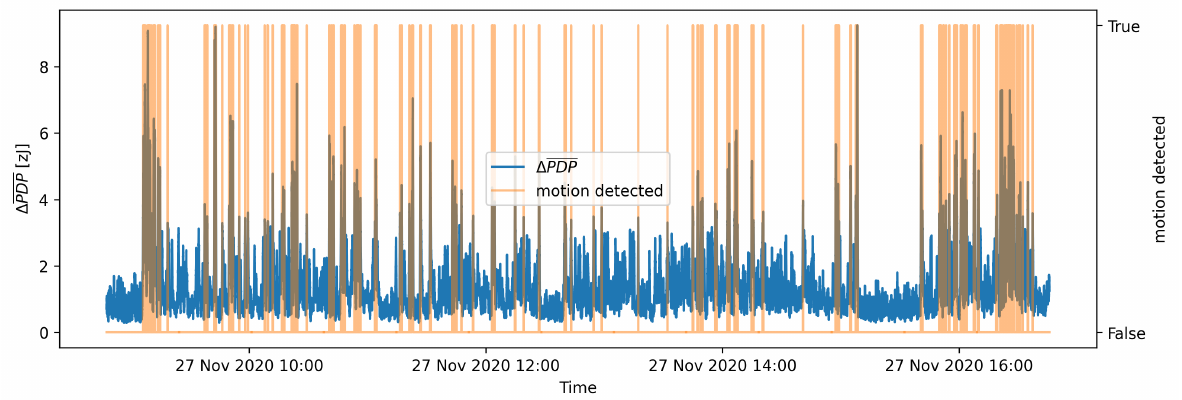
Figure 7. Results of the batch processing motion detection algorithm with k = 5 for a part of validation data